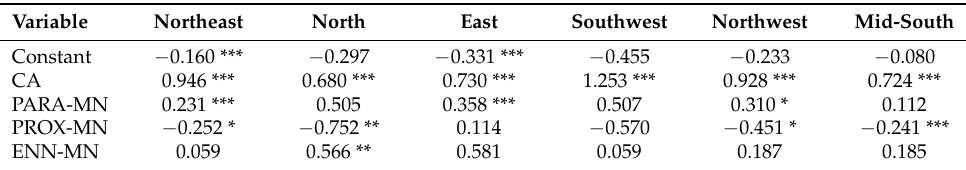
Table 5. OLS results statistics based on administrative divisions. Variable Northeast North East Southwest Northwest Mid-South